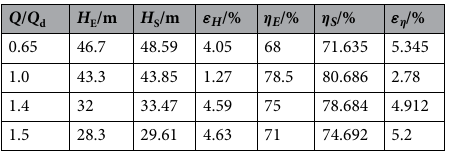
Table 2. Hydraulic performance parameters of the single-VLSFP.